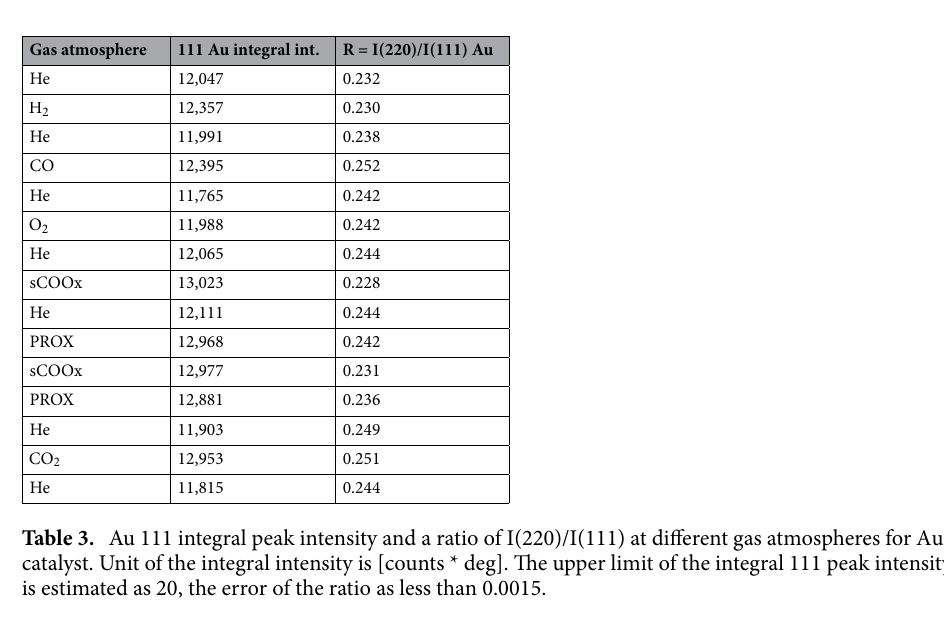
Figure 8. The estimated sample local temperature versus DP number.